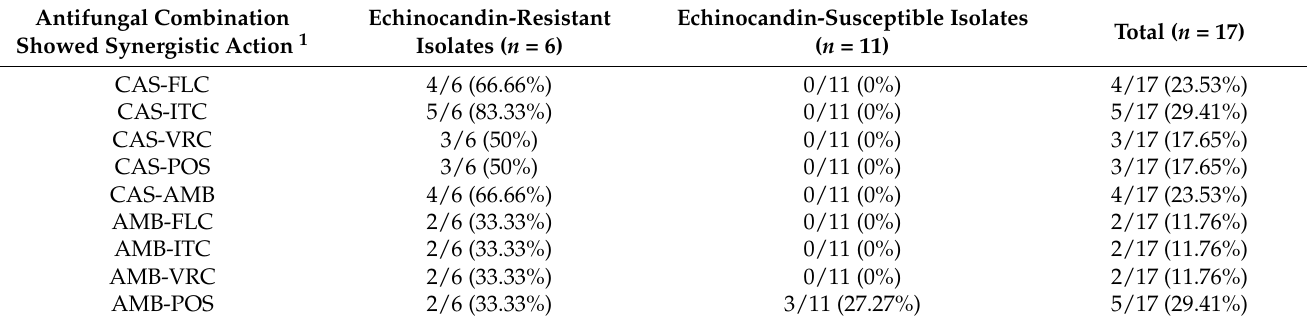
Table 5. Synergism percentage among echinocandin-resistant and -susceptible C. glabrata